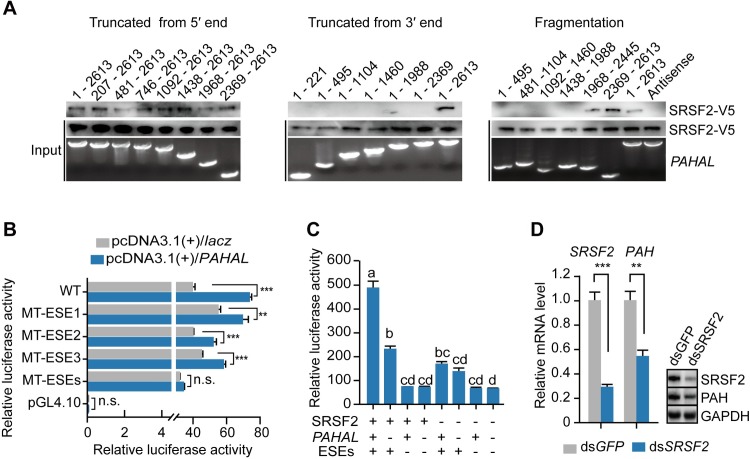
SRSF2 is recruited by the 3′ terminal of PAHAL to PAH 5′-UTR for the transcriptional activation of PAH.(A) Mapping analysis of the biotin-labelled fragments of PAHAL incubated with SRSF2-MEF lysates that overexpress the V5-tagged SRSF2 (SRSF2-V5) of locusts. (B) Mutational analysis of the activity of ESEs in PAH gene with the overexpressed PAHAL by using the luciferase assay. WT indicates wild type. MT-ESE1, MT-ESE2 or MT-ESE3 indicate mutated ESE1, ESE2 or ESE3 in the pGL4.10 vector, respectively. MT-ESEs indicate the mutation of all the three ESEs. (C) The interaction of PAHAL, SRSF2 and ESE promotes the transcription activation of PAH. Means labelled with different letters are significantly different (P < 0.05). The following vectors were transfected in SRSF2-MEFs: “ESE+”, P+5′-UTR (containing −554/+89 fragment without ESE mutation) in pGL4.10; “ESE−”, P+5′-UTR containing the mutated tandem ESEs; “PAHAL+”, the pcDNA3.1(+)/PAHAL; “PAHAL−”, the pcDNA 3.1(+)/lacz; “SRSF2+”, the pcDNA 3.1/V5-His/SRSF2; “SRSF2−”, the pcDNA3.1/V5-His /lacz. (D) SRSF2 knockdown by dsRNA injection reduces the PAH expression in the brain. Six replicates of eight brains were measured. Student’s t-test: *P < 0.05; **P < 0.01; ***P < 0.001; n.s., insignificant.